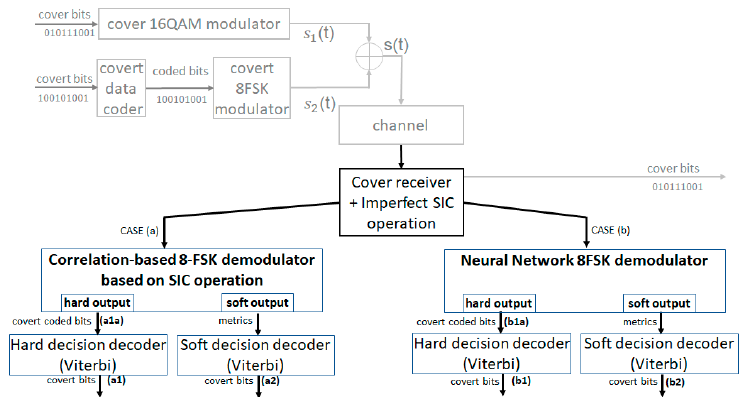
Figure 10. Block diagram of test scheme (all methods under test).